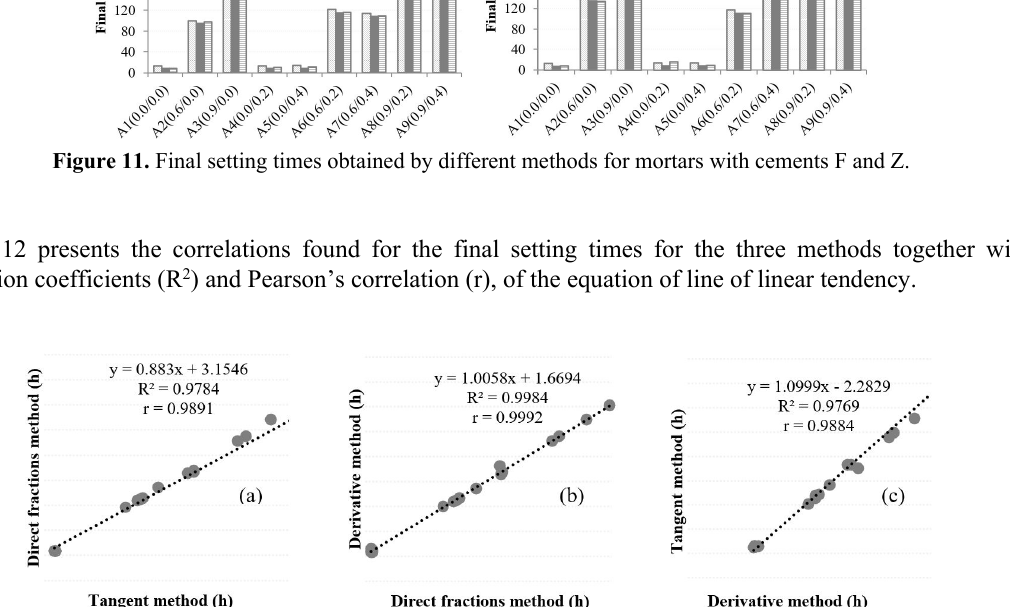
Figure 12. Correlation between the final setting times obtained by the tangent, direct fraction, and derivative